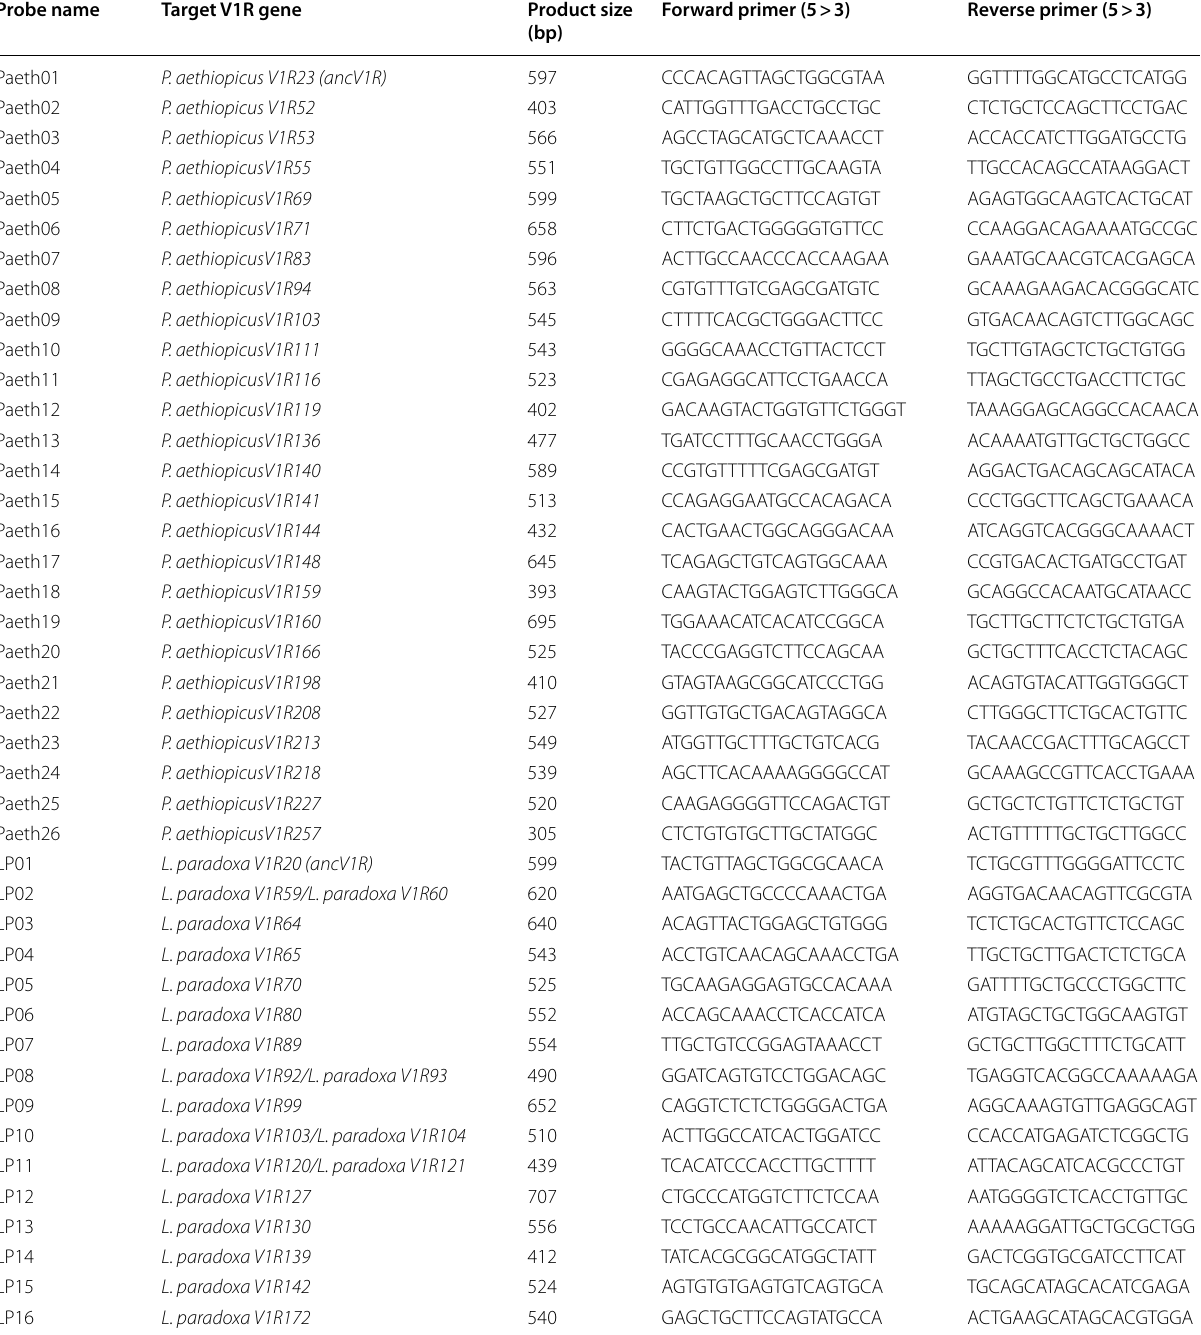
Table 2 Primers for